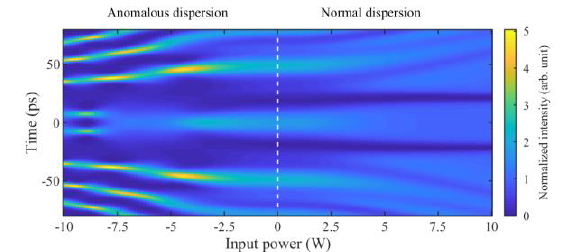
Fig. 3. Influence of the initial average power on the output pattern recorded after 10 km of propagation To discuss the influence of the value of the initial phase offset we have carried out additional simulations. The resulting pattern can be significantly different with a loss of the temporal symmetry for the single jump case. Breathing solutions may appear in the anomalous regime of propagation and grey solitons are observed instead of black ones in the normal regime of dispersion. When non- ideal phase jumps are considered (i.e. the transition between the two phase states has a given duration), the nonlinear pattern will also be affected by this additional initial